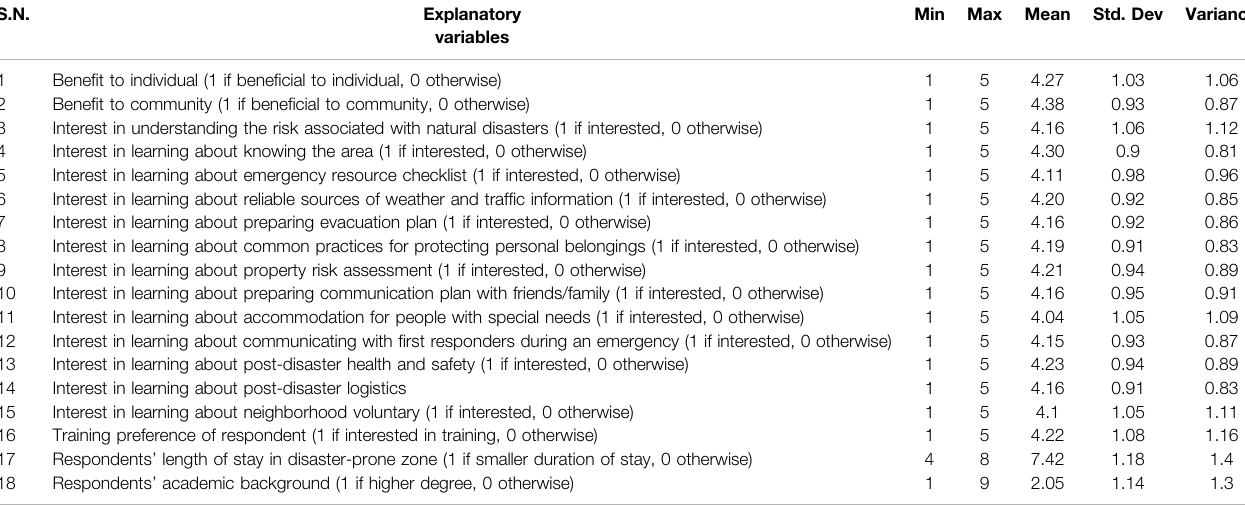
TABLE 2 | Descriptive statistics of explanatory variables. S.N.